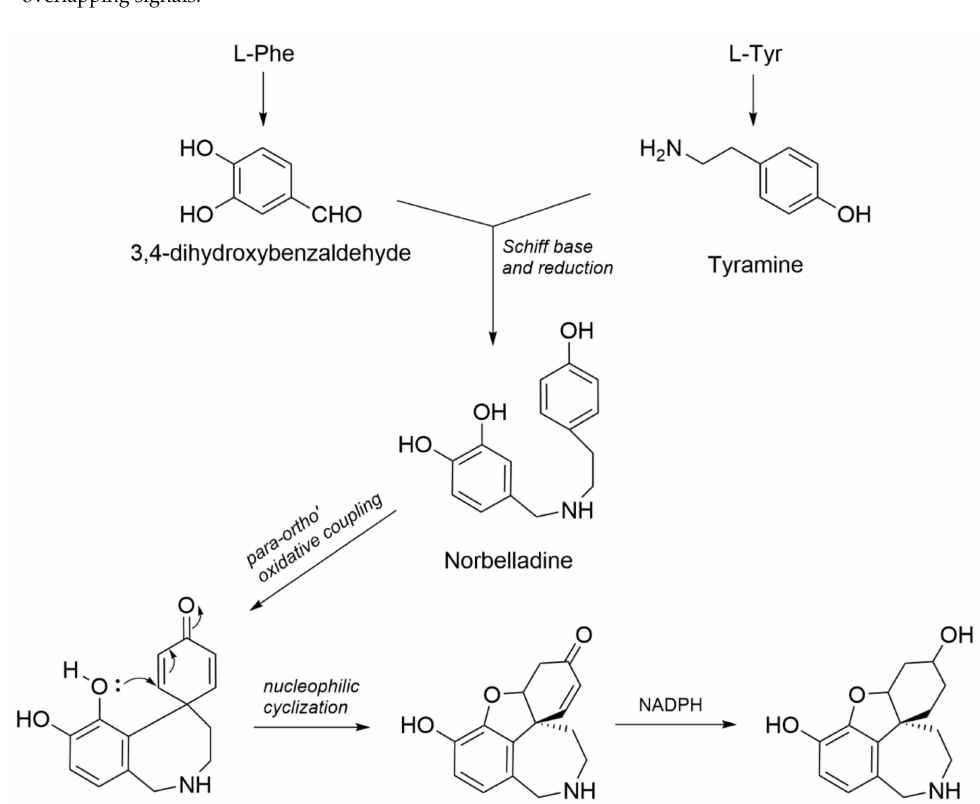
Figure 3. Proposed biosynthetic scheme of compound 1